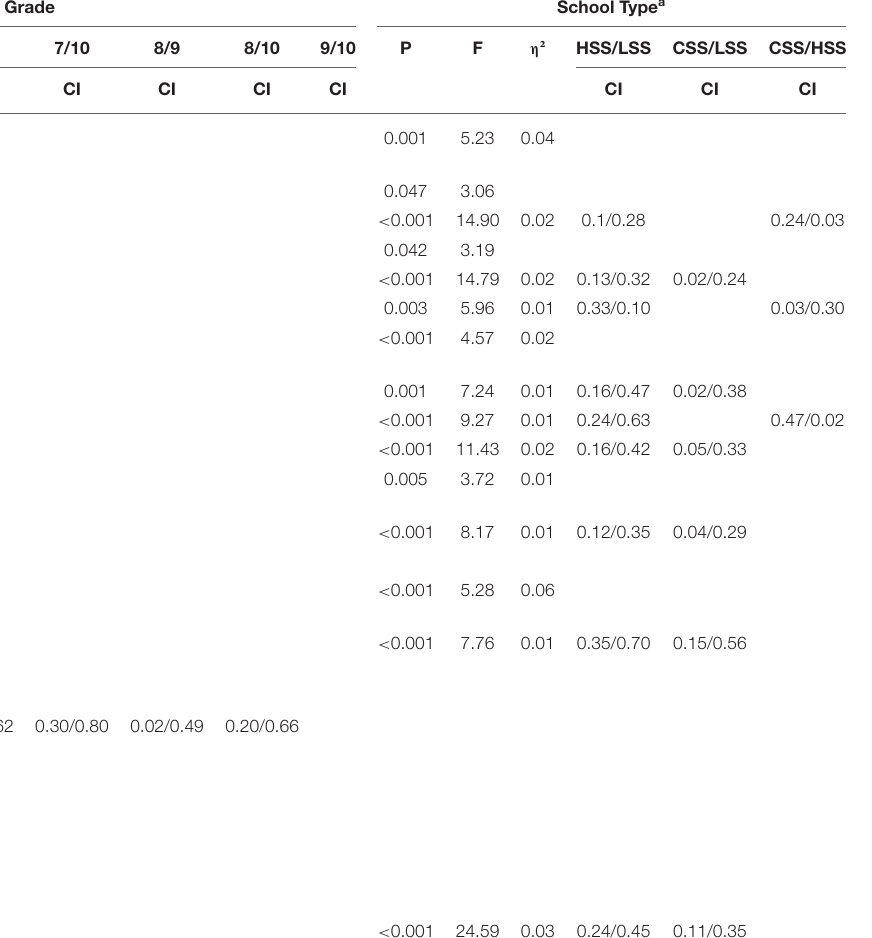
TABLE 3 | Significant differences in student characteristics between students’ gender, grade, and school type. Variable Gender Grade School Type